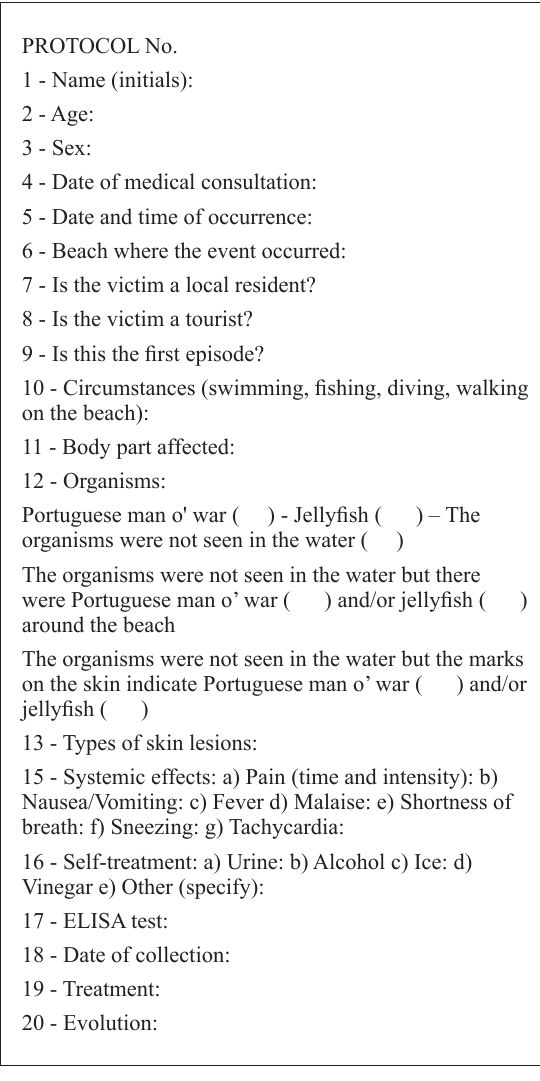
Protocol assessment of incidents with